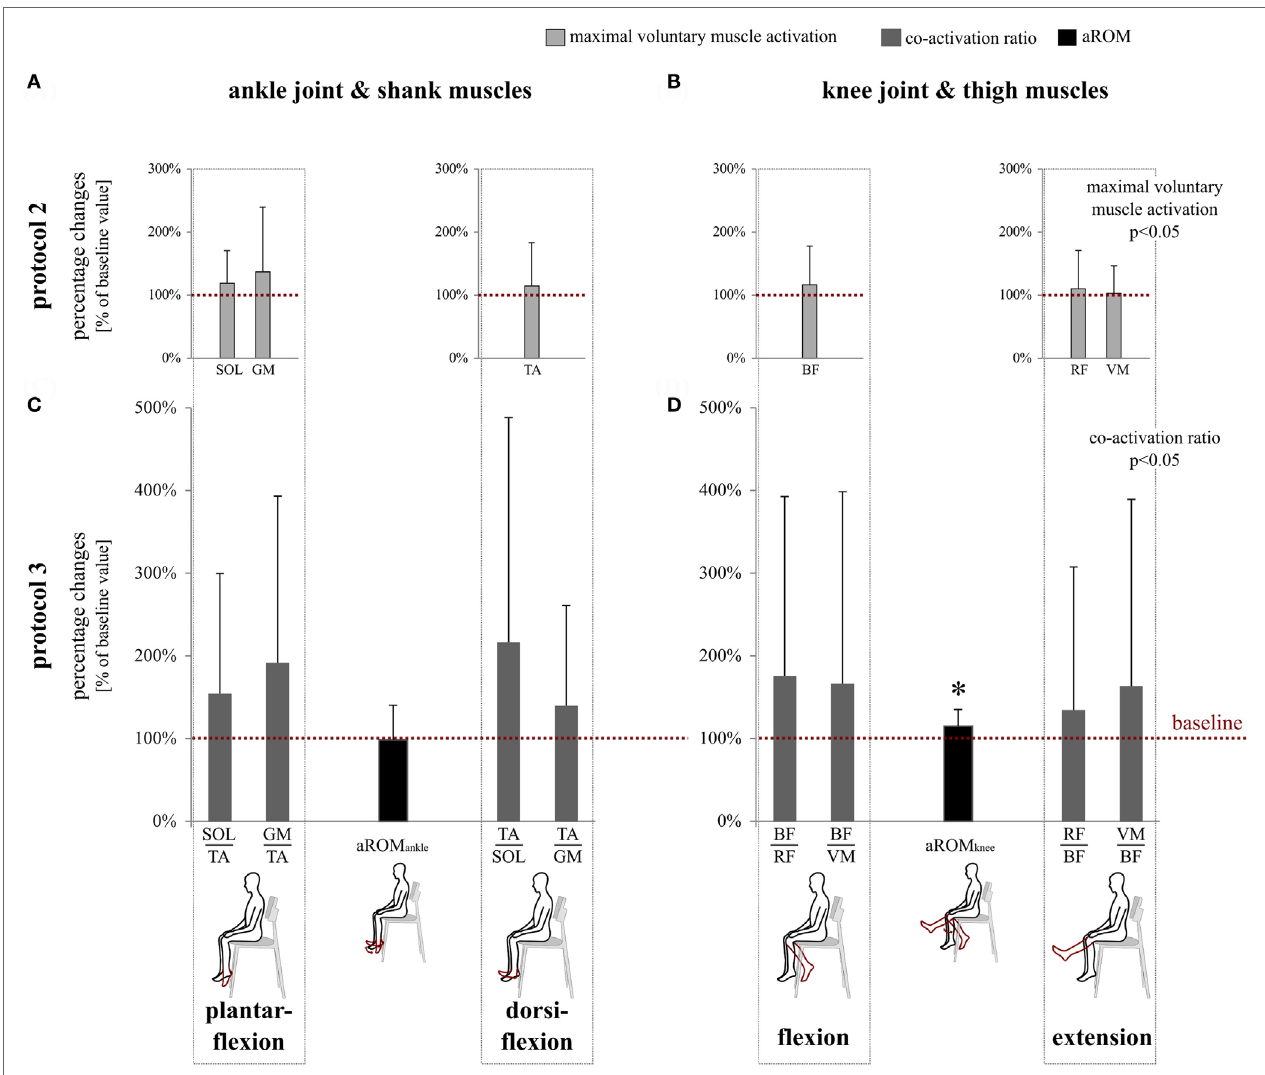
FigUre 4 | This graph illustrates percent changes in neuromuscular and kinematic parameters. The red dotted lines serve as references and mark baseline values at 100% referring to data collected before whole-body vibration (WBV). (a) Modulations of maximal voluntary muscle activation for the antagonist muscles encompassing the ankle joint [m. soleus (SOL), m. gastrocnemius medialis (GM), and m. tibialis anterior (TA)] and (B) knee joint [m. biceps femoris (BF), m. rectus femoris (RF), and m. vastus medialis (VM)] for joint flexion and extension. The rmANOVA revealed a significant increase ( p < 0.05) in response to WBV. (c) WBV-induced modulations in co-activation ratios of the muscles surrounding the ankle joint and (D) knee joint and corresponding active ranges of motion (aROM). The rmANOVA revealed a significant increase in co-activation ratios ( p < 0.05) and knee joint excursion ( p < 0.05) in response to WBV. Data are normalized to control values obtained prior to WBV. Significant changes in aROM are illustrated by * p <